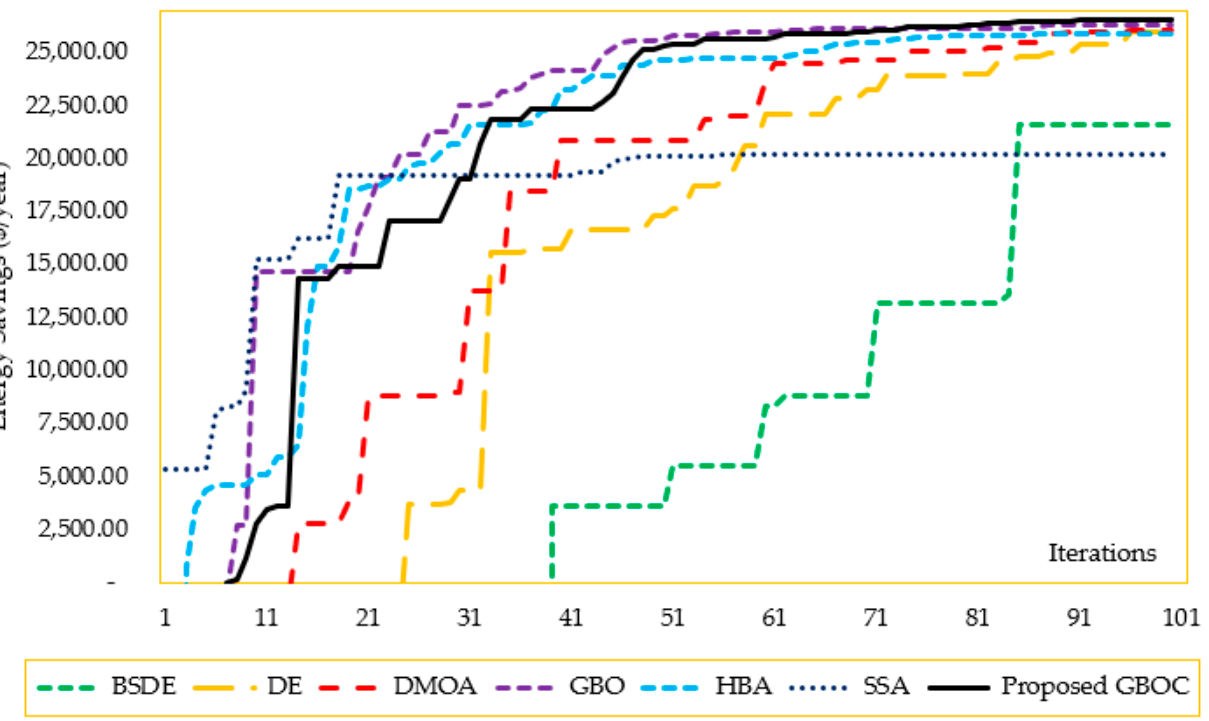
Figure 16. Convergence characteristics of GBOC, GBO, SSA, DMOA, DE, and HBA for the IEEE 69-distribution system for Scenario 2.